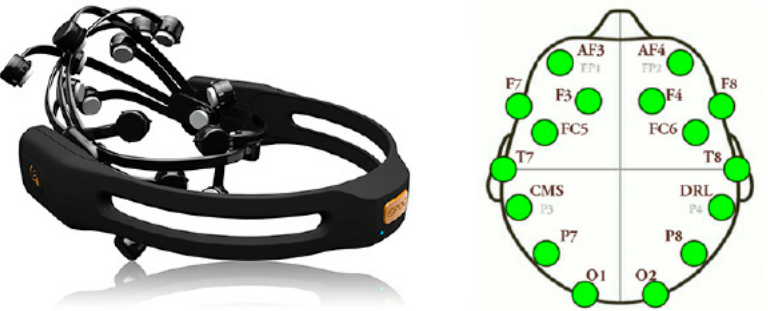
Figure 7. Emotiv Epoc+ headset and electrodes location (Emotiv, San Francisco, CA, USA).